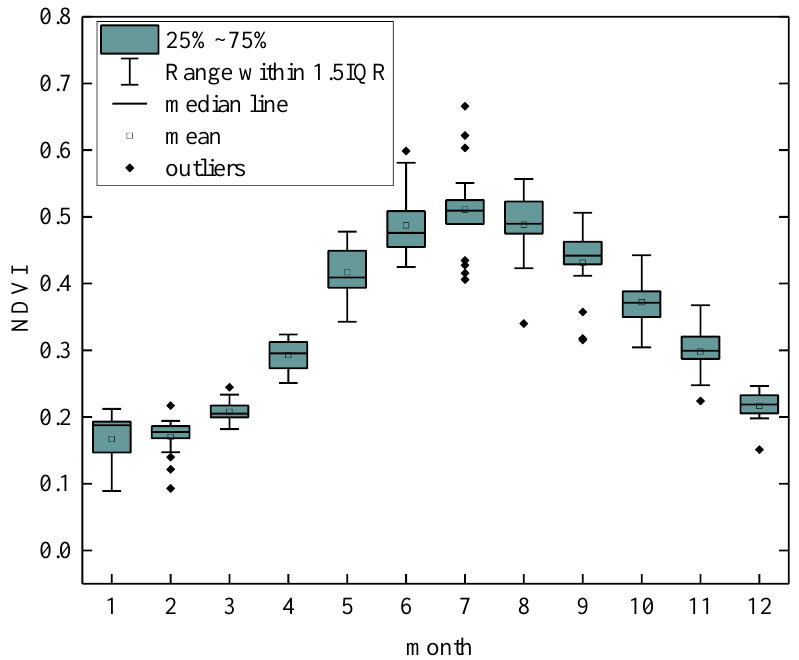
Figure 5. Seasonality of Monthly NDVI.